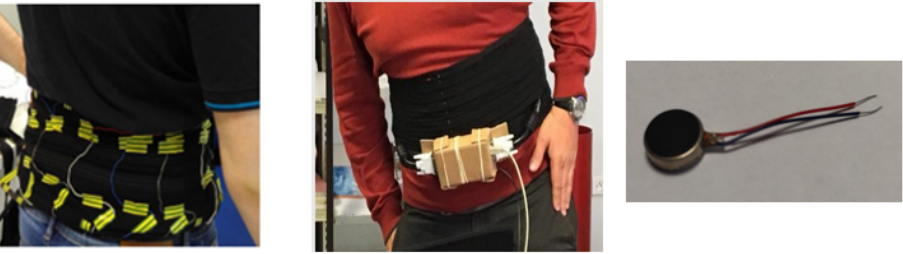
Figure 7. TactiBelt prototype ( left , showing vibrator positions, and center , showing the complete device) and type of used vibrator ( right , RS DC minivibration